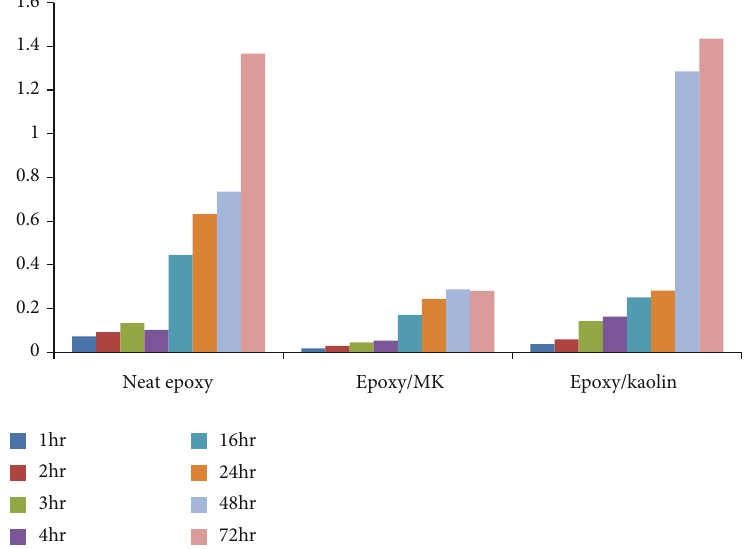
Figure 7: Weight gain vs. time of water immersion of neat epoxy, epoxy/MK, and epoxy kaolin